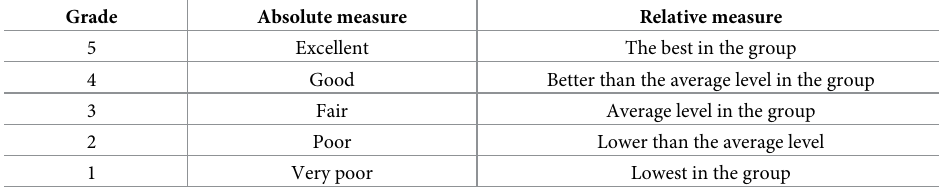
Table 4. Subjective method for image quality assessment.